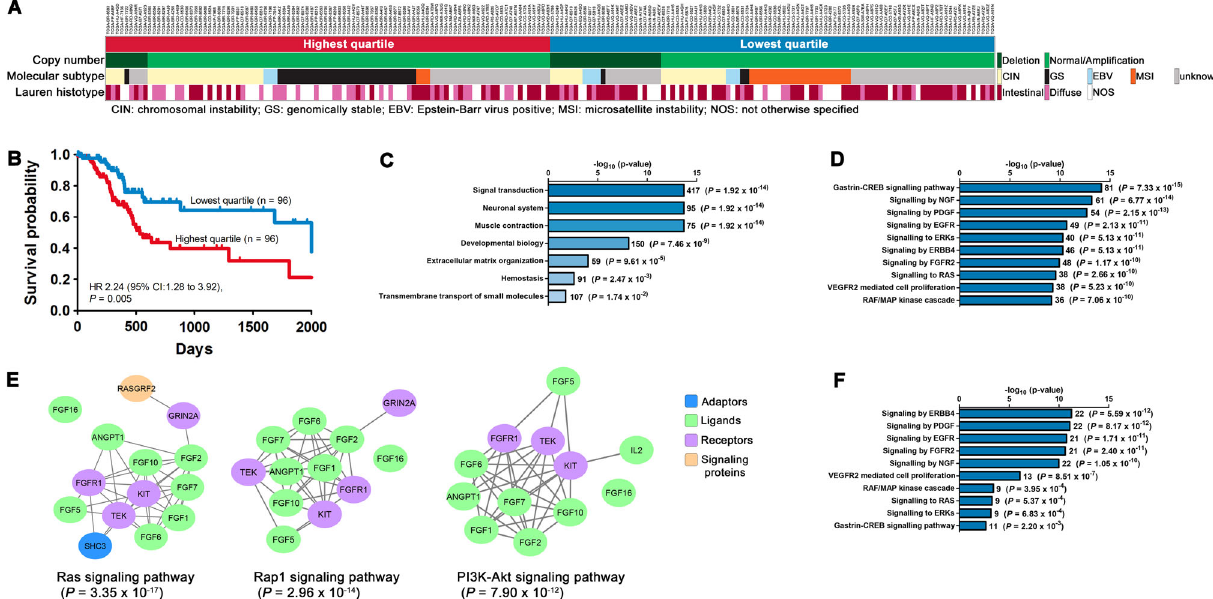
Fig. 2 Clinicopathological correlations of gastric cancers with DOK6 expression. a Association of the highest and lowest quartiles of DOK6 - expressing gastric cancers with FRA18C copy number status, Lauren histotype and molecular subtype. Columns represent individual gastric cancer tumors of the respective quartiles. b Kaplan – Meier survival plot showing longer survival of patients in the lowest quartile. Data for ( a ) and ( b ) are from the TCGA STAD study. c Processes mapped by Reactome for genes underexpressed in the lowest compared to the highest quartile. d Top 10 canonical pathways represented by 417 genes of the signal transduction process in ( c ). e Signaling pathways enriched in 34 core genes present in all 10 pathways in ( d ) by STRING analysis. f Signaling pathways enriched in differentially expressed proteins (RPPA data). The number of genes and FDR-corrected P -values are shown for each bar in ( c , d and